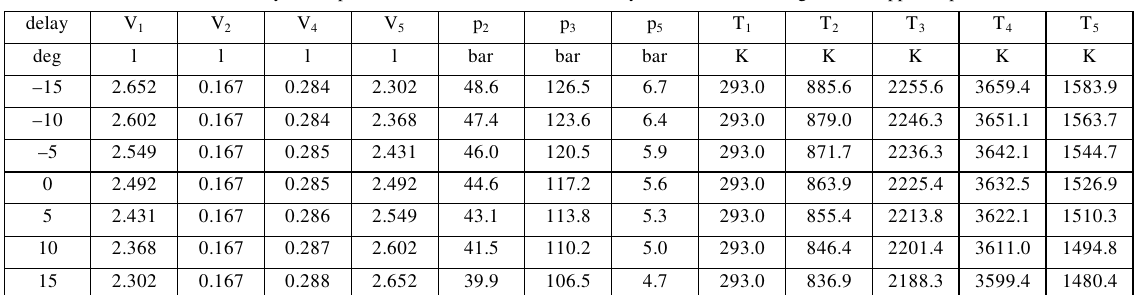
Table 2. Thermodynamic parameters of theoretical Atkinson cycle of two-stroke engine with opposed pistons